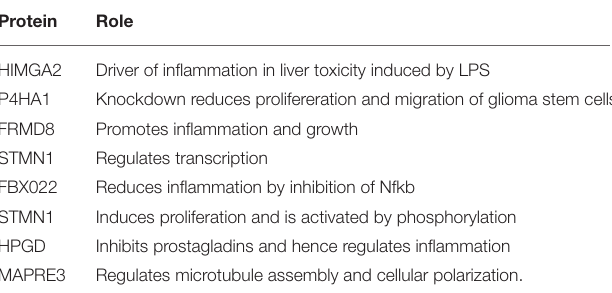
TABLE 2 | PD risk genes demonstrating differential protein expression in microglia following α Syn Agg . Protein